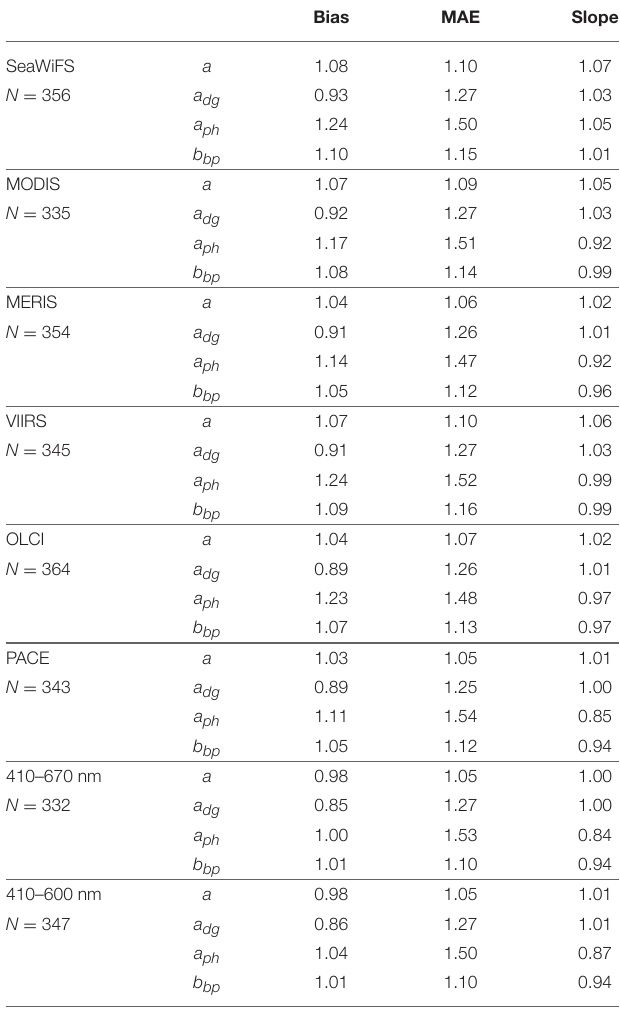
and report the median UPD for the complete population of TABLE 1 | Statistics for SAA-derived vs. synthesized IOPs at 443nm. match-ups. A negative UPD indicates that the IOP from satellite 2 Bias MAE Slope is biased low relative to satellite 1 SeaWiFS 1.08 1.10